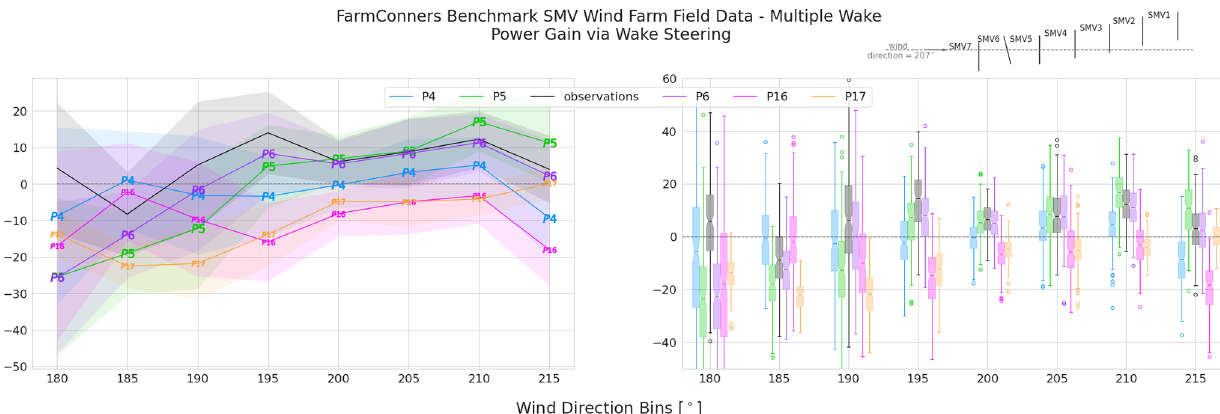
Figure A3. SMV WF field data, multiple wake under wake steering WFFC with − 13 . 3 ◦ upstream misalignment – power gain comparison. Representative layout with corresponding yaw control setting is illustrated at the upper right corner.